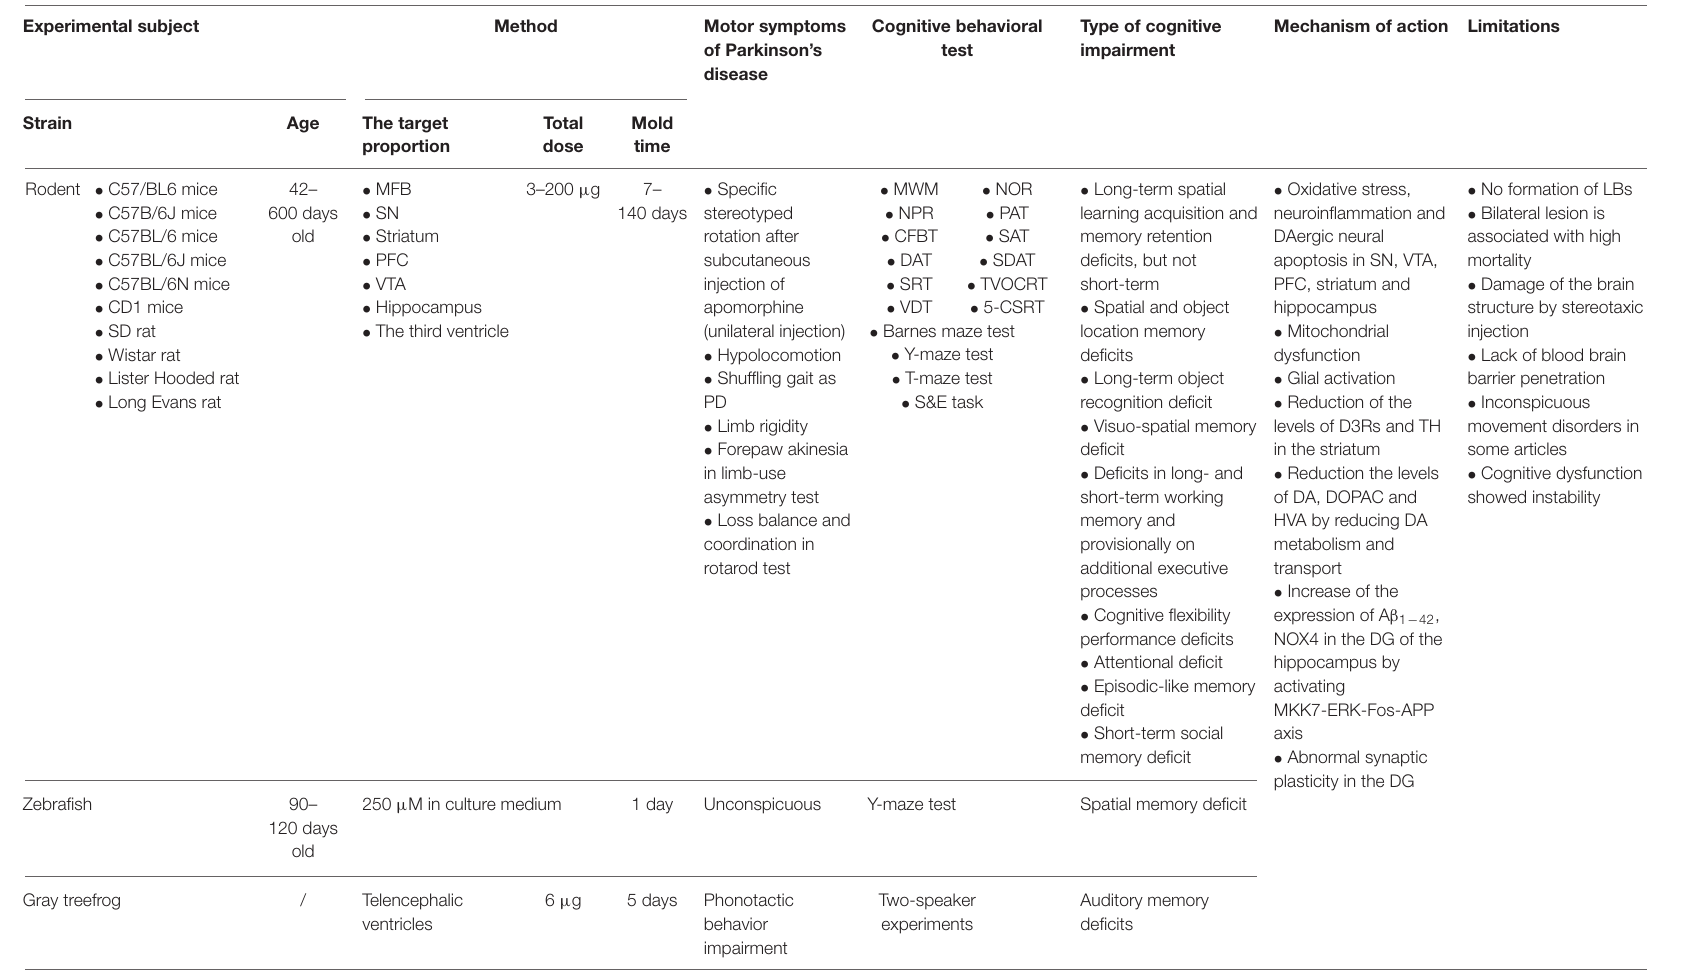
TABLE 3 | Methods of 6-OHDA-induced experimental